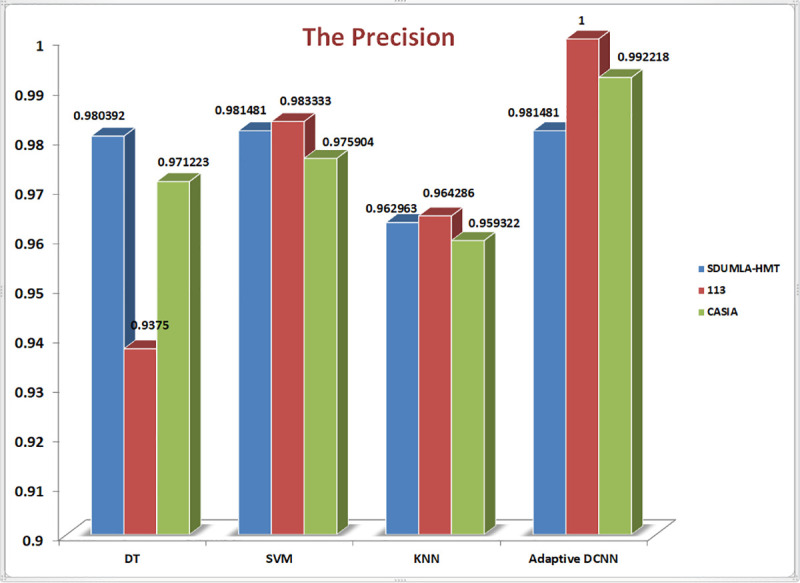
Precision of our proposed system and the three comparison systems.